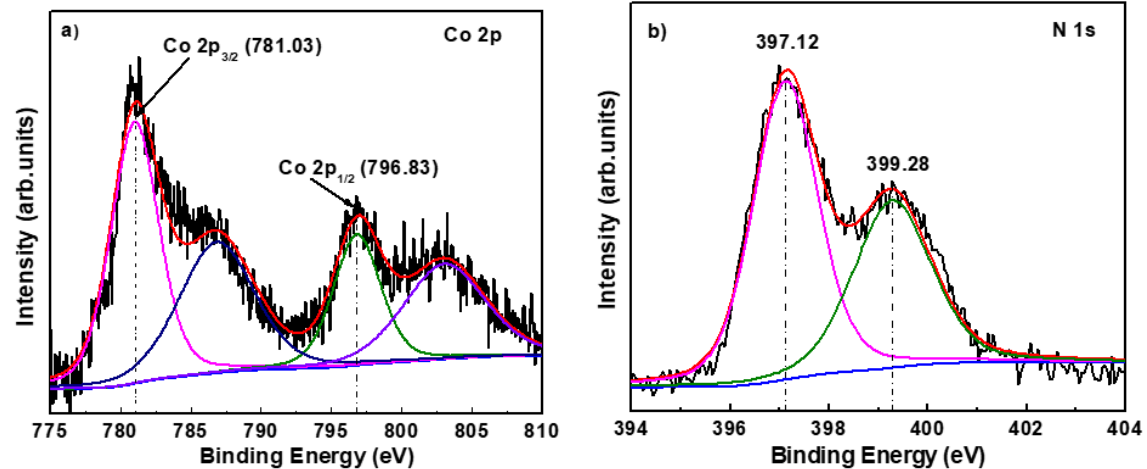
Figure 4. ( a ) The Co XPS of specimen B5#. ( b ) The N XPS of specimen B5#.